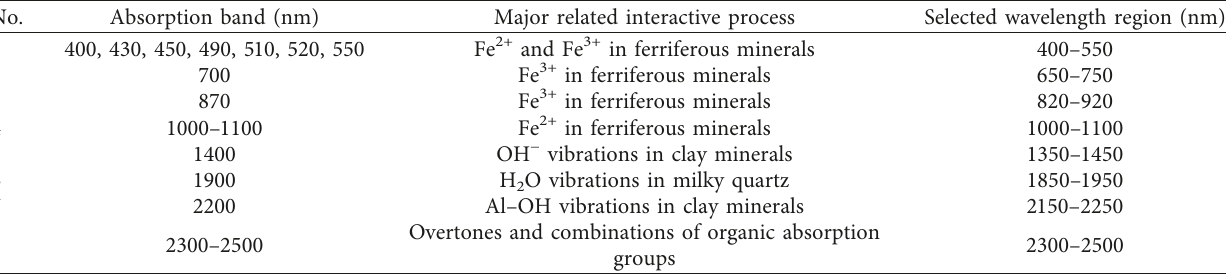
Table 1: Spectral regions related to the major compositions [27–30].